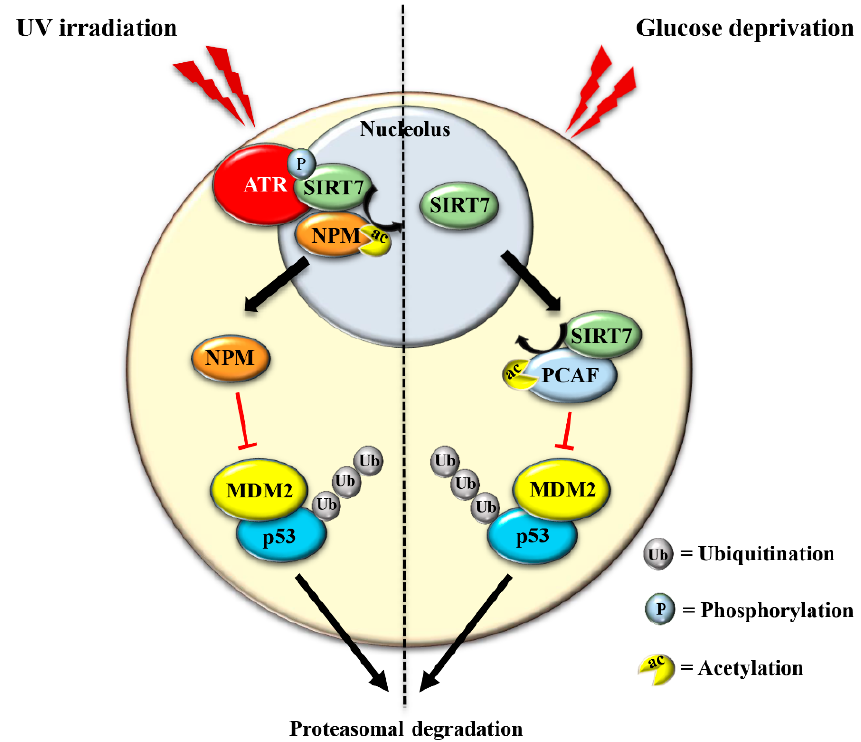
Figure 3. SIRT7 promotes p53 stabilization in response to distinct stressors. In response to UV-induced stress, SIRT7 is activated by ATR-mediated phosphorylation. Activated SIRT7 efficiently deacetylates its nucleolar target nucleophosmin (NPM), facilitating its exclusion from nucleoli. Deacetylated NPM binds and inhibits the ubiquitin ligase MDM2, thereby preventing MDM2- dependent ubiquitination and subsequent proteasomal degradation of p53 (left panel). In response to glucose starvation, SIRT7 translocates from the nucleolus, associates and deacetylates PCAF, which favors PCAF-mediated degradation of MDM2, leading to p53 stabilization (right panel).